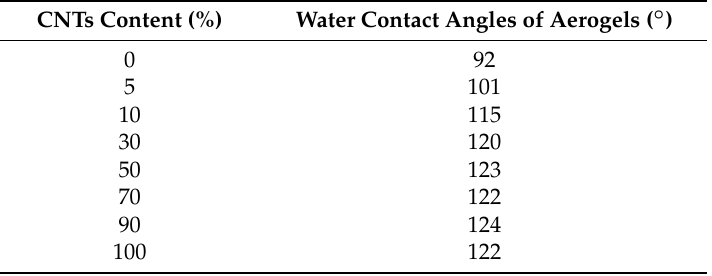
Table 2. Water contact angles of aerogels with different CNTs content.